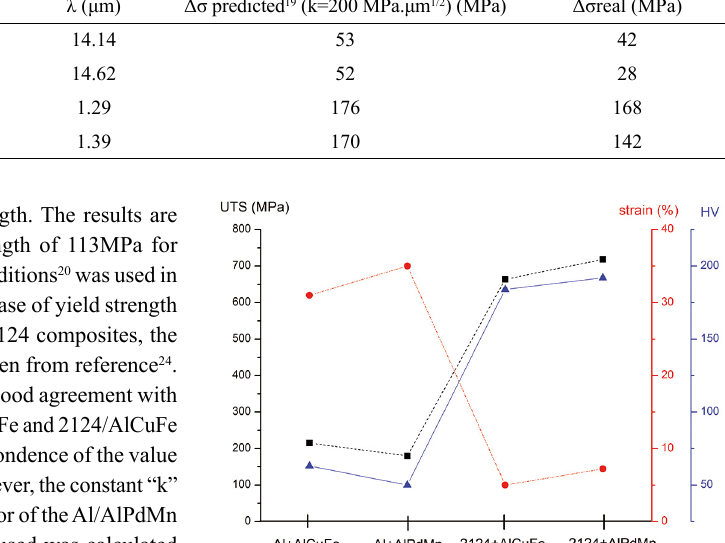
Table 1: Equivalent Yield strength, matrix ligament size, predicted increase of yield strength using k from reference 19 and the real increase of yield strength presented by the composites. Composite